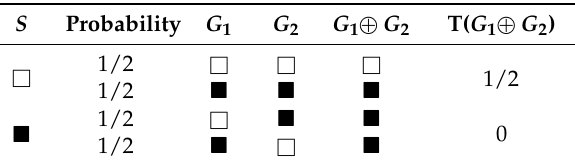
Table 2. The transmittance of the Algorithm